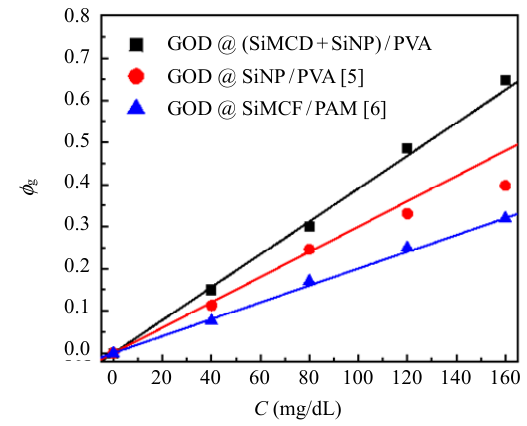
Fig. 8 Volume fraction of the glucose in the GSM versus concentration of the